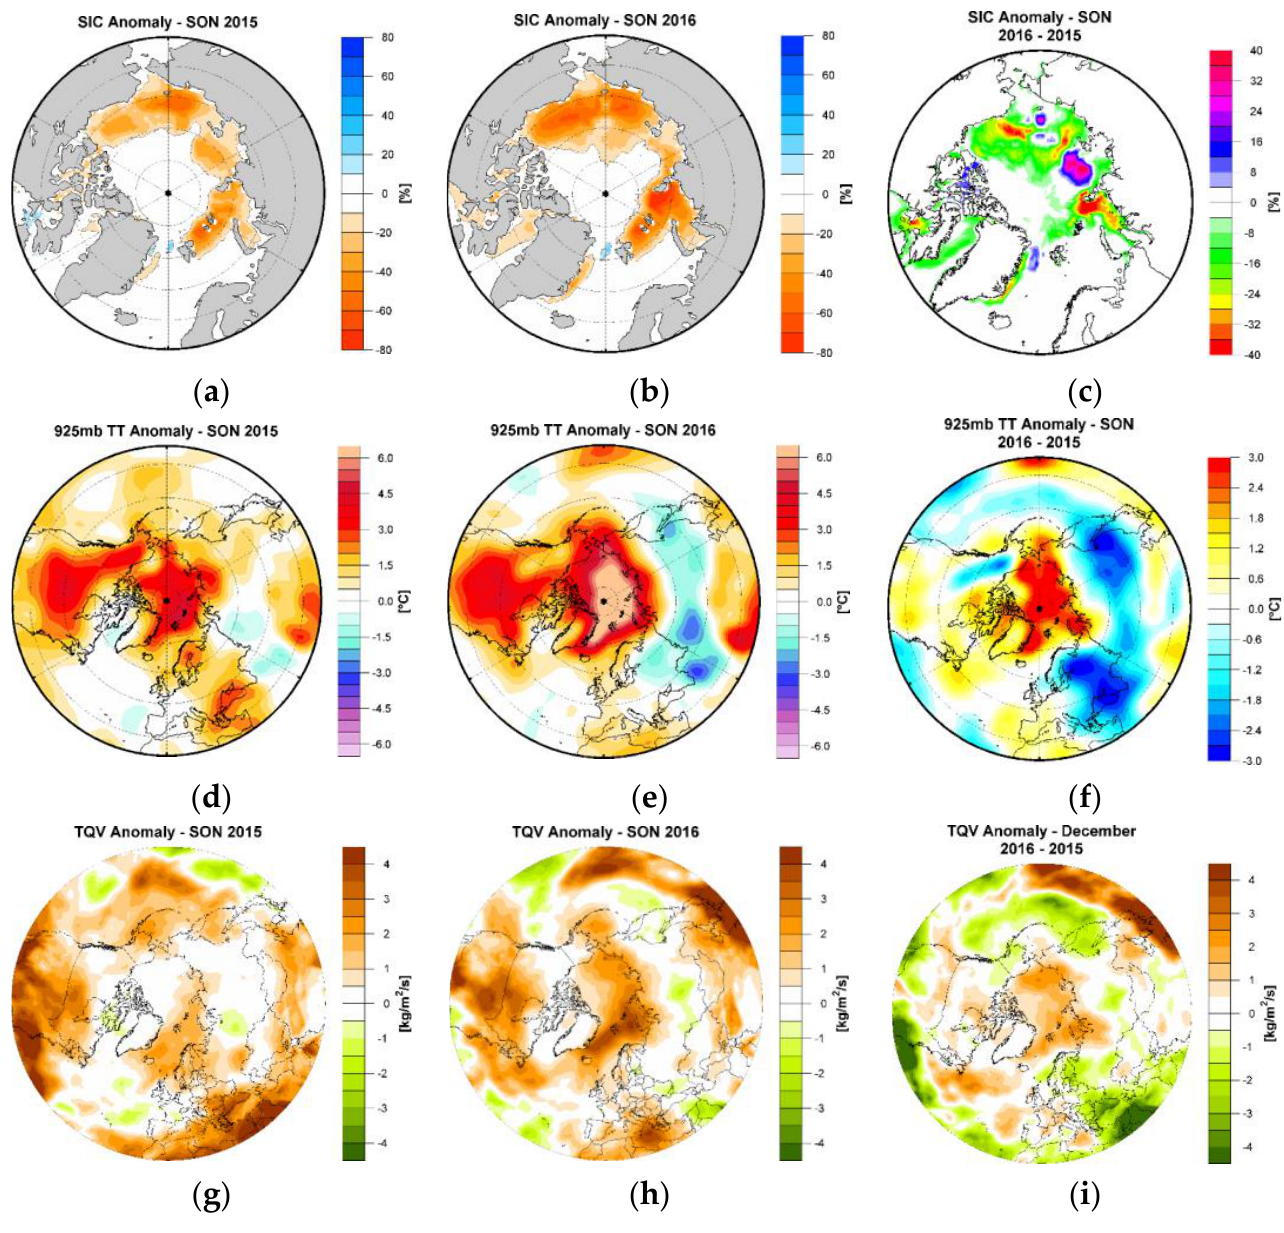
Figure 5. Pre-conditioning: ( a ) sea ice concentration (SIC) anomalies for autumn 2015; ( b ) sea ice Figure concentration (SIC) anomalies for autumn 2016; ( c ) difference between ( a ) and ( b ); ( d ) 925 mb tem- perature anomalies for autumn 2015; ( e ) 925 mb temperature anomalies for autumn 2016; ( f ) differ- ence between ( d ) and ( e ); ( g ) total precipitable water vapor (TQV) anomalies for autumn 2015; ( h ) total precipitable water vapor (TQV) anomalies for autumn 2016; and ( i ) difference between ( g ) and ( h ).